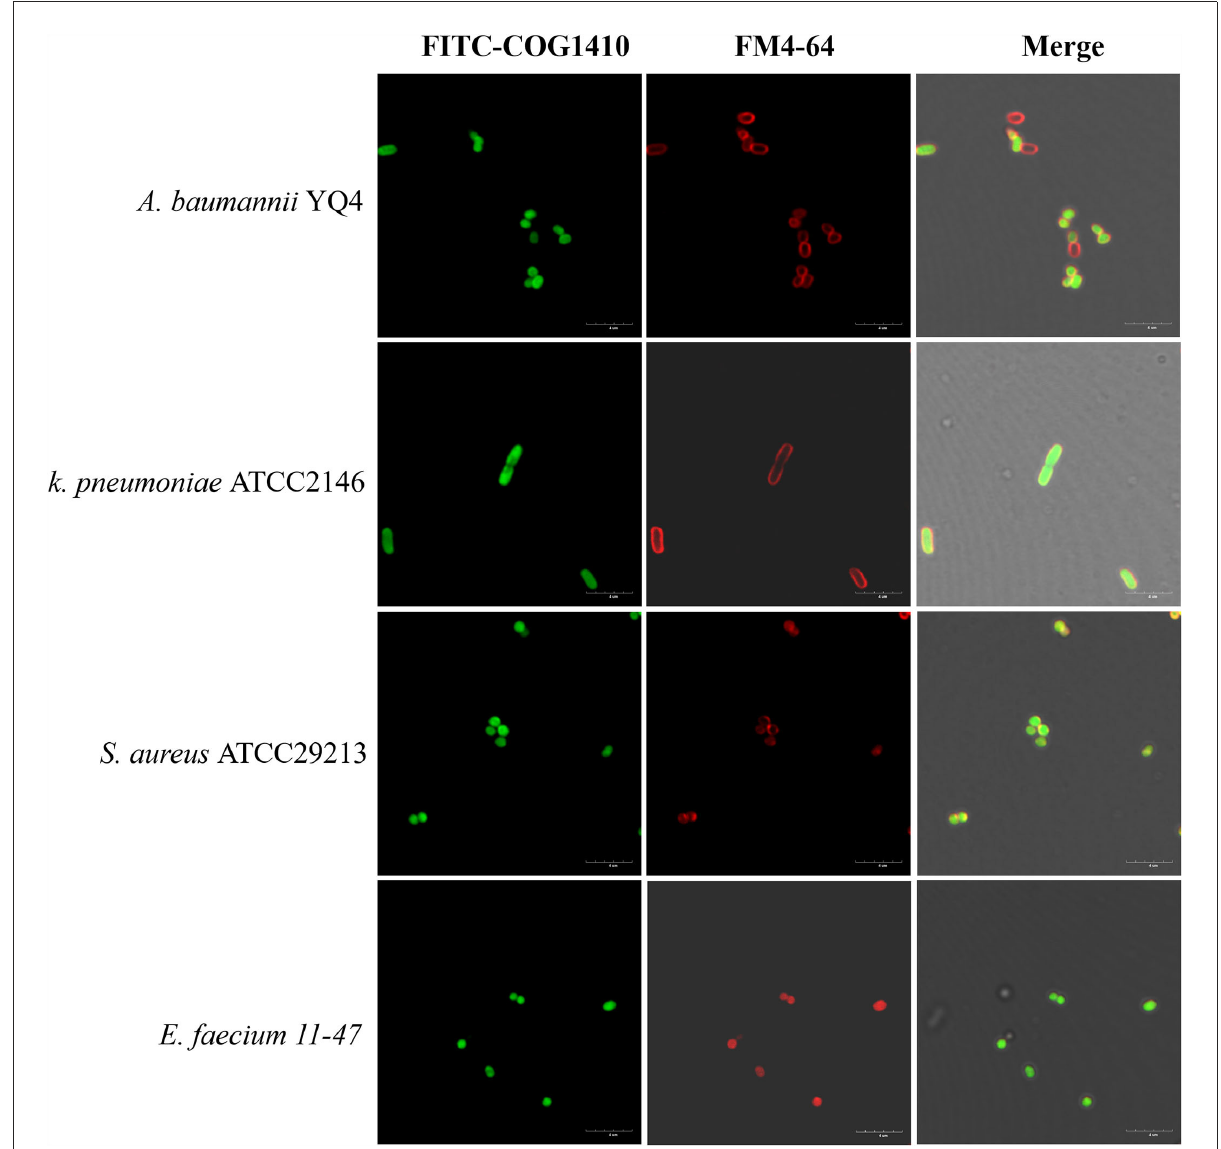
FIGURE4 FITC-COG1410 entered the cytoplasm of A. baumannii , E. faecium , K. pneumoniae, and S. aureus . The bacteria were treated with FITC-COG1410 and stained with FM4-64 dye and observed by CLSM. The green fluorescence indicates the localization of FITC-COG1410 in the cells. Red fluorescence indicated the cytoplasmic membrane. Scale bar: 4 µ m.